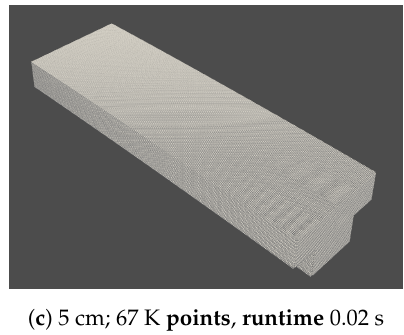
Figure 6. Various resolutions of the 3D reconstruction. The high resolutions shown in ( a , b ) show more points to clearly defined surfaces and edges. The medium resolutions shown in ( c ) show enough points to define the structure of the object. The low resolutions shown in ( d ) show less points describing the object.